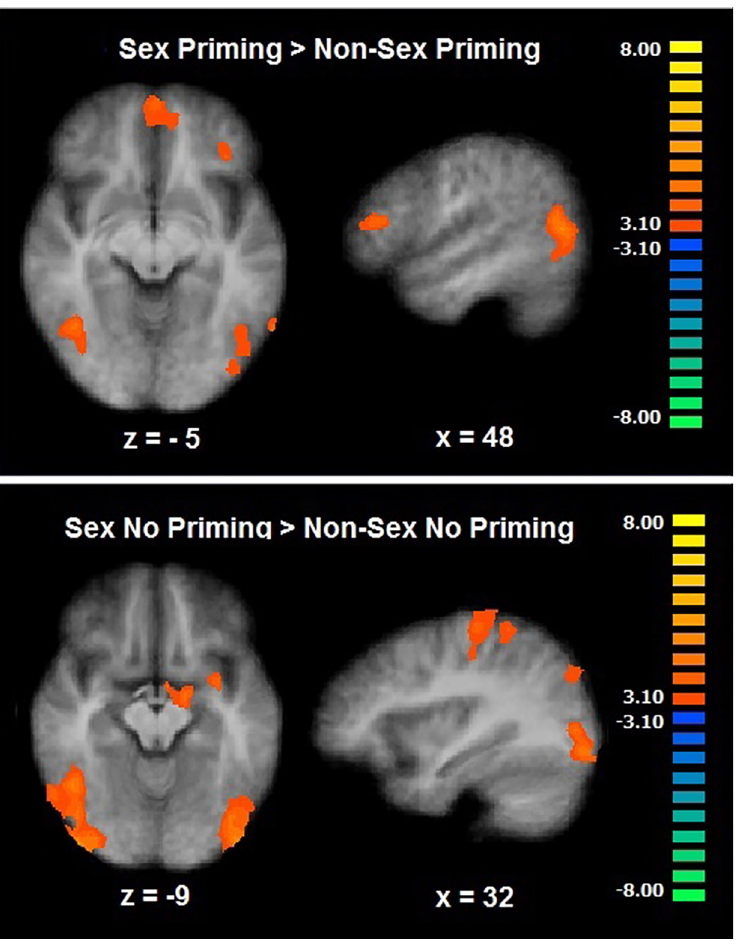
Fig 6. Cognitive sexual inhibition—Negative affective priming task. Brain activation during the Sex Priming (up) and Sex No Priming trials (down) (CLTC, p < .005).